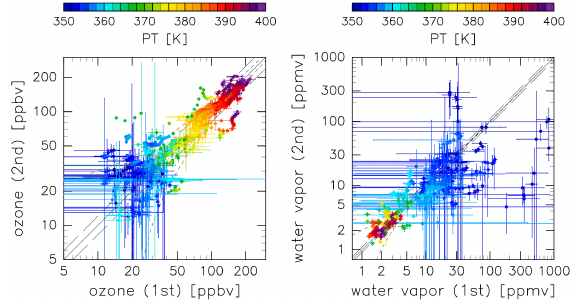
Fig. 2. Scatter plots showing the first (abscissa) versus the second observed values (ordinate) of ozone (left) and water vapor (right) mixing ratios for all preliminary matches connected by match air parcel. Color indicates the potential temperature. Bars in both pan- els indicate the uncertainties estimated by Hasebe et al. (2013), a companion paper to the present study. The dashed lines oriented parallel to the diagonal in the left panel indicate a difference of ± 20% between the paired observations, and the dotted curves indi- cate the range of ± 20ppbv difference for the paired ozone mixing ratio. These are the thresholds of acceptable difference used in this study (see the last part of Sect. 3.3). Lines in the right panel indi- cate the accuracy of water vapor measurements; i.e., ± 10% (dashed lines) and ± 1ppmv (dotted lines) (see Sect. 2). Note that the water vapor data measured by the Snow White hygrometers are not plot- ted above 360 K by their performance problem (see Sect. 2).